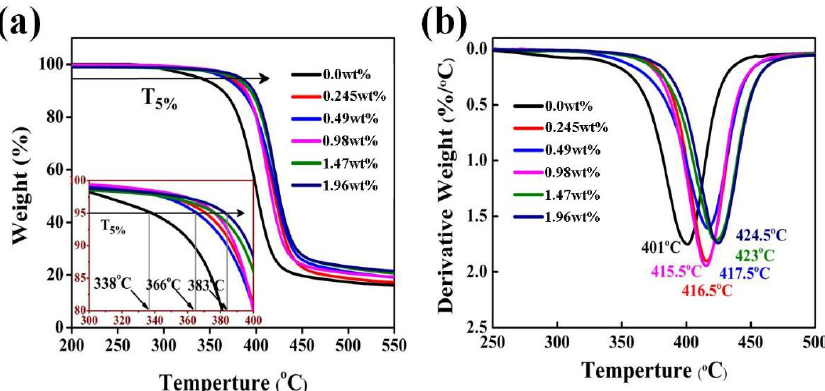
Figure 10. ( a ) TGA curves; and ( b ) DTG curves of epoxy/GPLP composites.